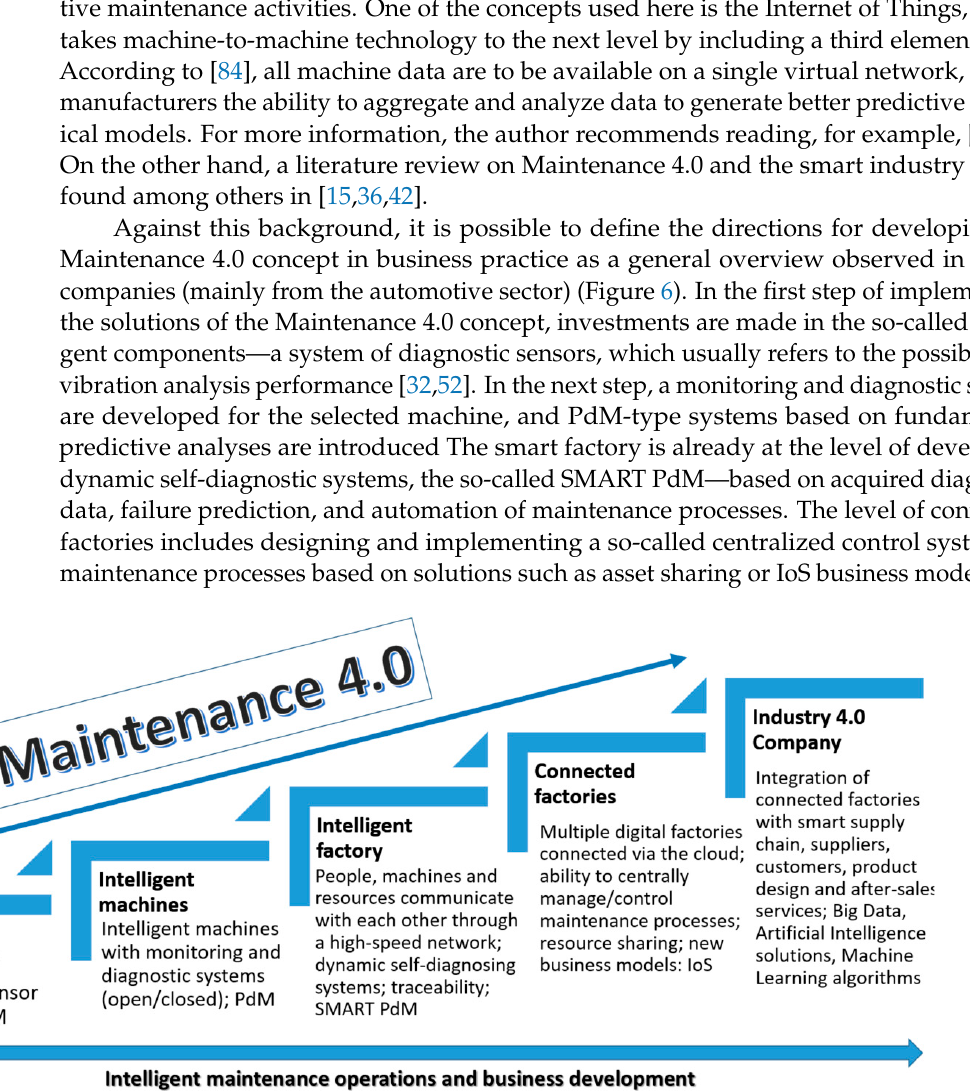
Figure 7. Technologies enabling PdM processes in the context of Industry 4.0. Source: own contri- bution based on [53,86,87]. A key issue, therefore, is the continuous monitoring and analysis of the physical asset network, which enables [88]: •